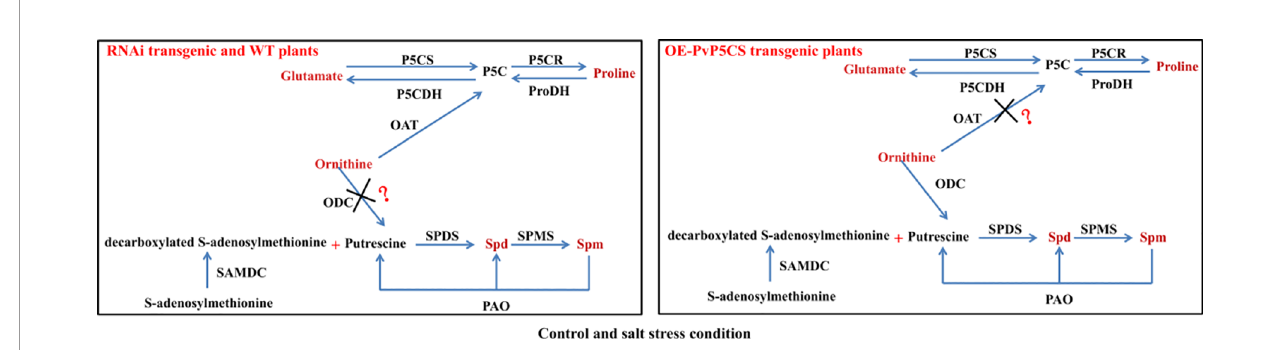
FIGURE 9 | Schematic illustration of a working model depicting the relationship between proline and polyamine in wild type, PvP5CS OE and RNAi transgenic plants under control and salt stress conditions. In summary, proline metabolism is in cooperation with polyamines metabolism in switchgrass. If switchgrass has enough proline to confer salt stress, ornithine could be as substrate involved in PAs biosynthesis. However, under less proline accumulation to improve the salt tolerance of switchgrass, ornithine will be used as a precursor entering the pathway of proline synthesis. Altogether, proline and polyamine metabolism cooperated to improve salt tolerance